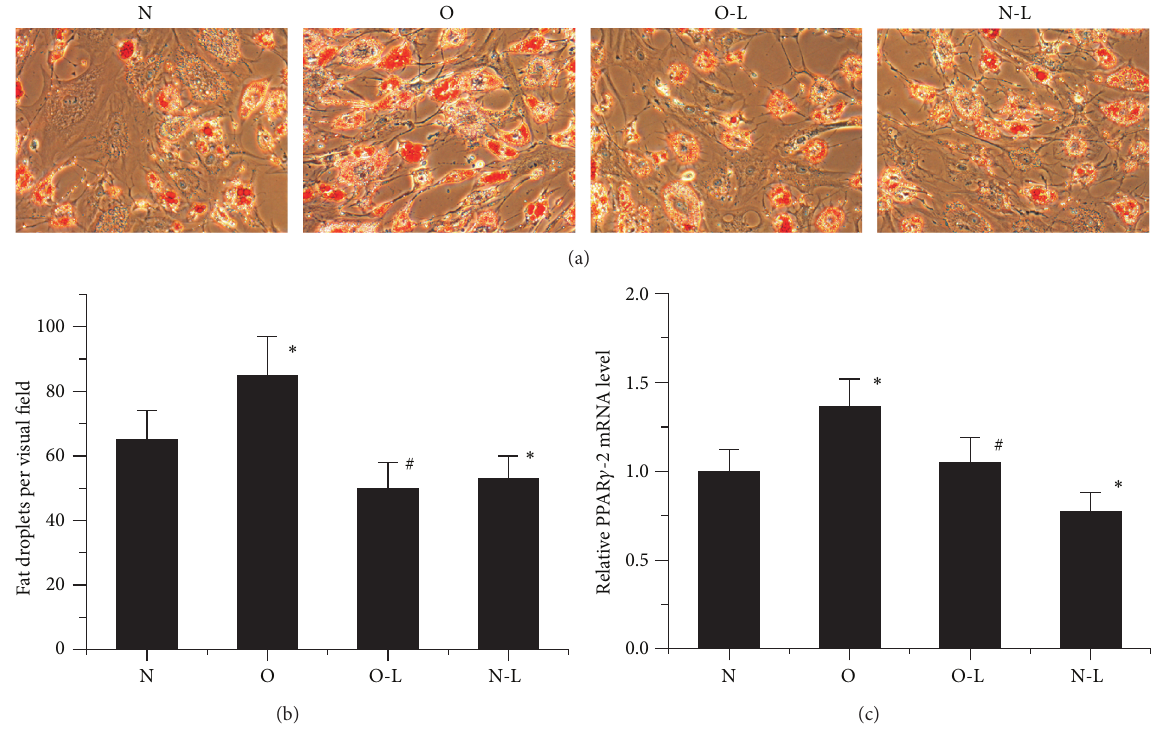
Figure 3: Effect of low oxygen on MSC adipogenic differentiation. (a) Oil Red O staining was performed to measure adipocyte formation 21 days after cells were induced in an adipogenic induction medium. (b) Fat droplets per visual field were determined. (c) Expression of PPAR 𝛾 -2 mRNA was determined by qRT-PCR at day 10. The data were drawn from three independent experiments and the results were expressed as mean ± SD. ∗ 𝑃 < 0.05 versus N Group. # 𝑃 < 0.05 versus O